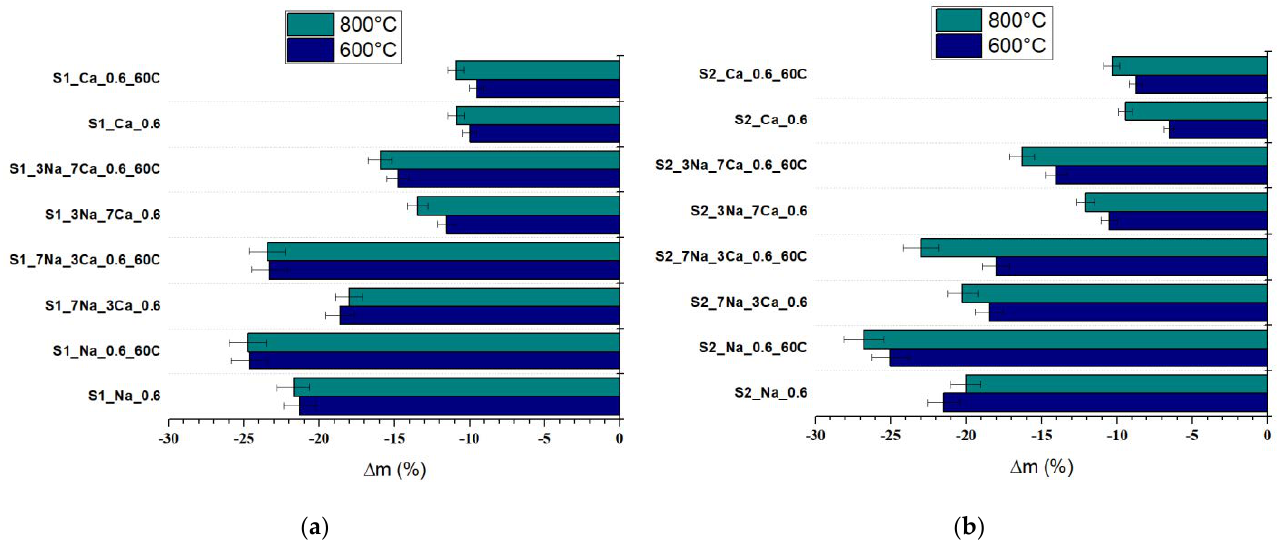
Figure 12. Mass changes vs. temperature for ( a ) samples obtained with S1 glass powder and ( b ) samples obtained whit S2 glass powder.